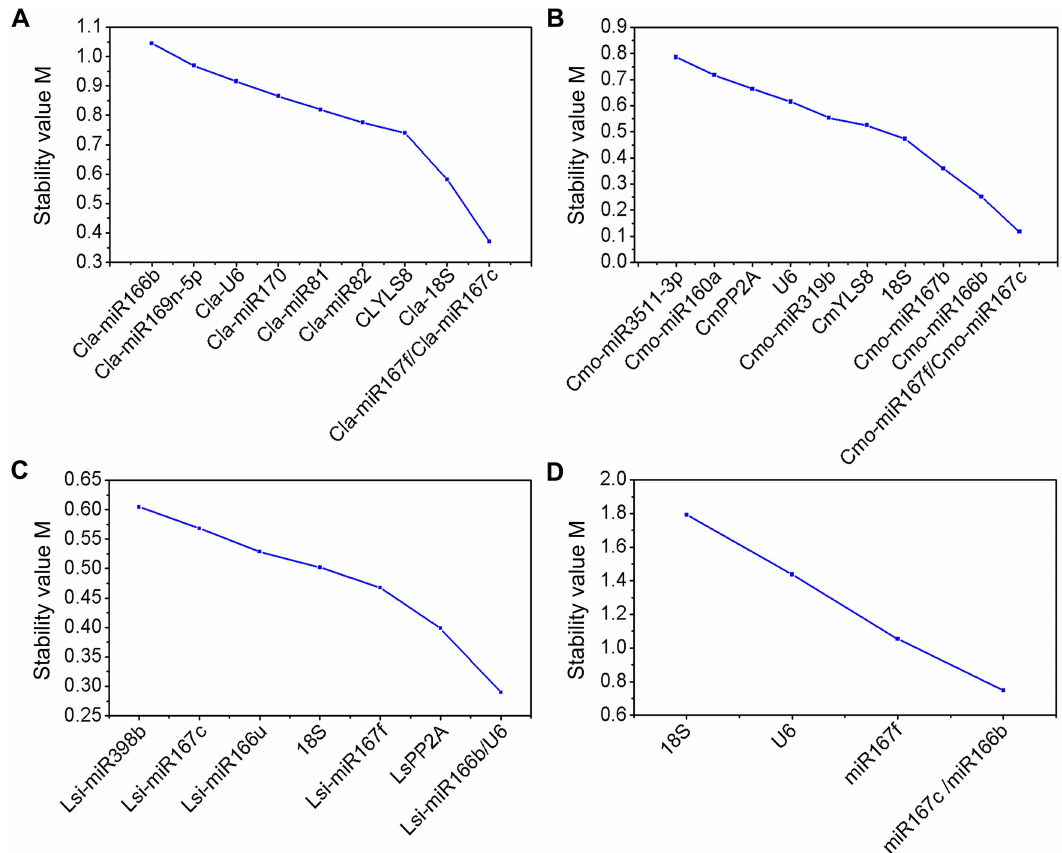
Fig 2. Average expression stability values (M) of the tested candidate referencegenes determined by geNorm. Stability value of each reference gene was evaluatedfrom four sample subsets: (A) scion leaves of different grafted watermelons submitted to N or P stress, (B) roots of grafted and non-graftedsquash submitted to N or P stress, (C) roots of grafted and non-grafted bottle gourd submitted to N or P stress, (D) all scion leaves of different grafted watermelons and roots of grafted and non-graftedrootstocks under normal conditions. The most stable reference genes were measured during the stepwise exclusionof the least stable reference genes. The lower the M values the more stable expression of candidatereference